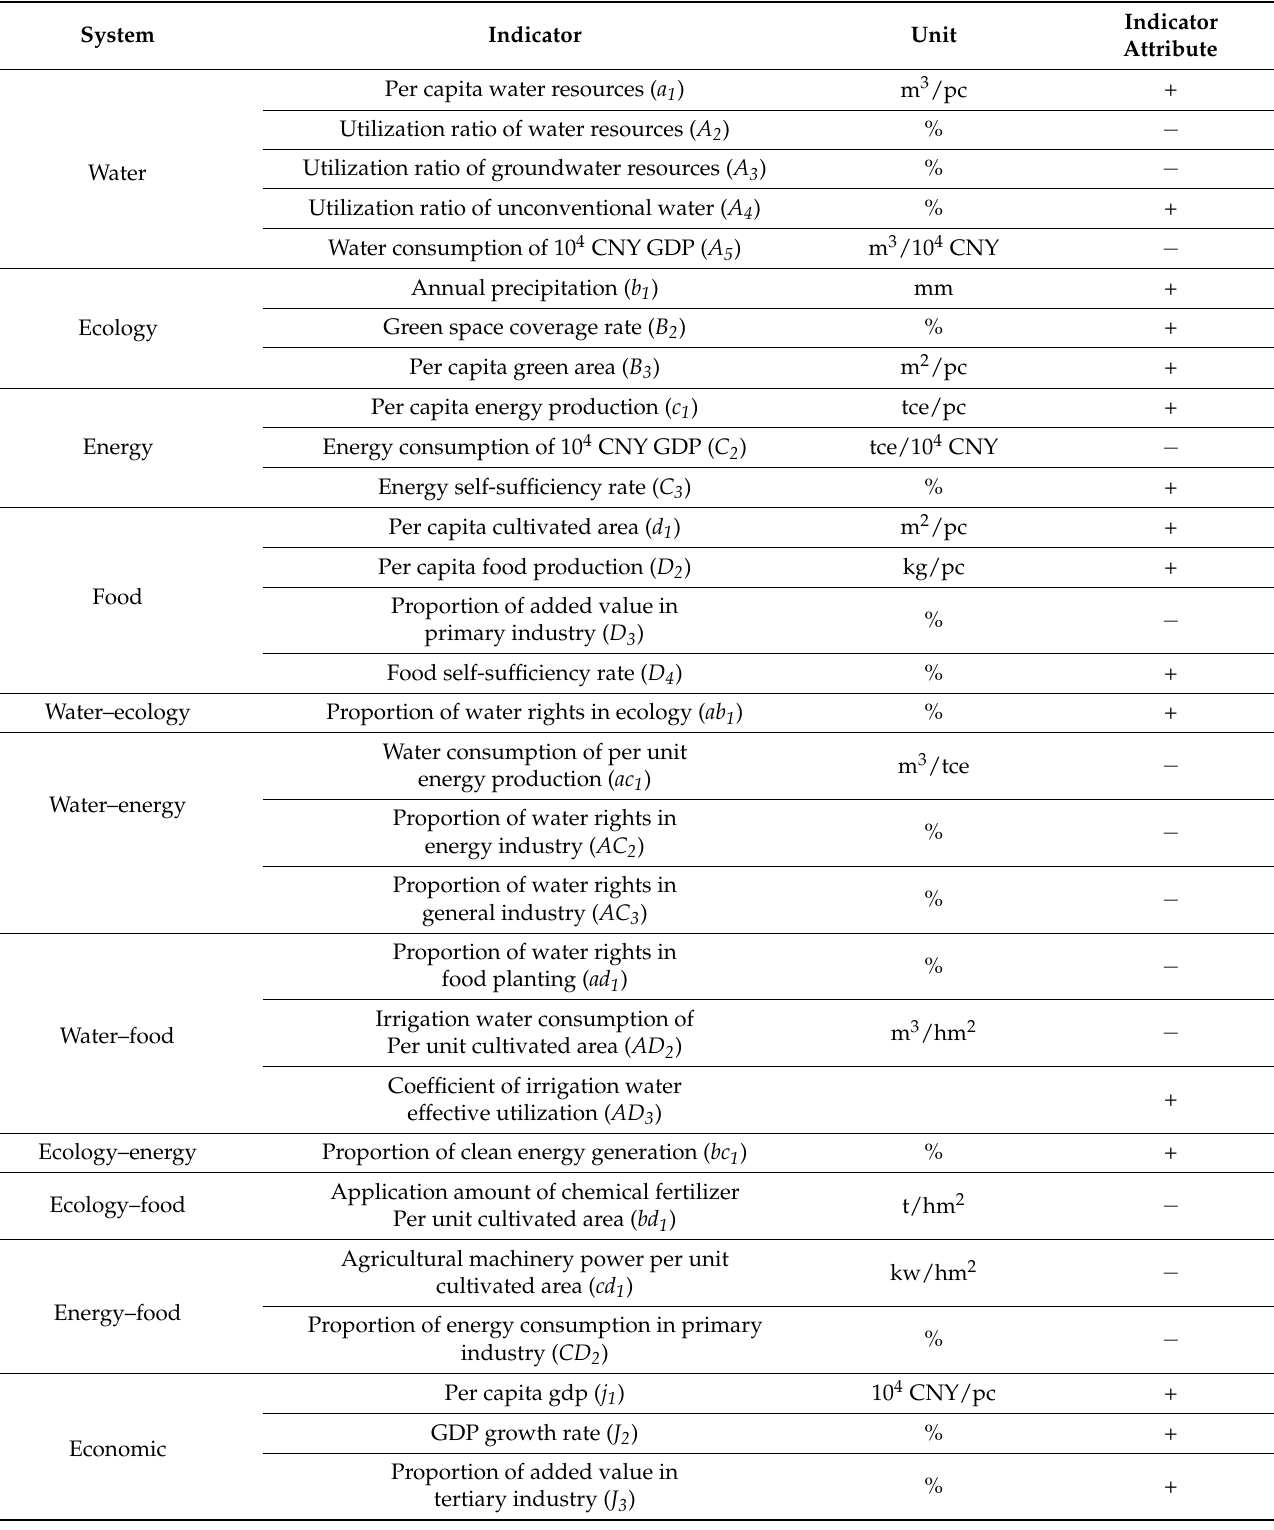
Table 1. The comprehensive evaluation indicators of water–ecology–energy–food coordinated